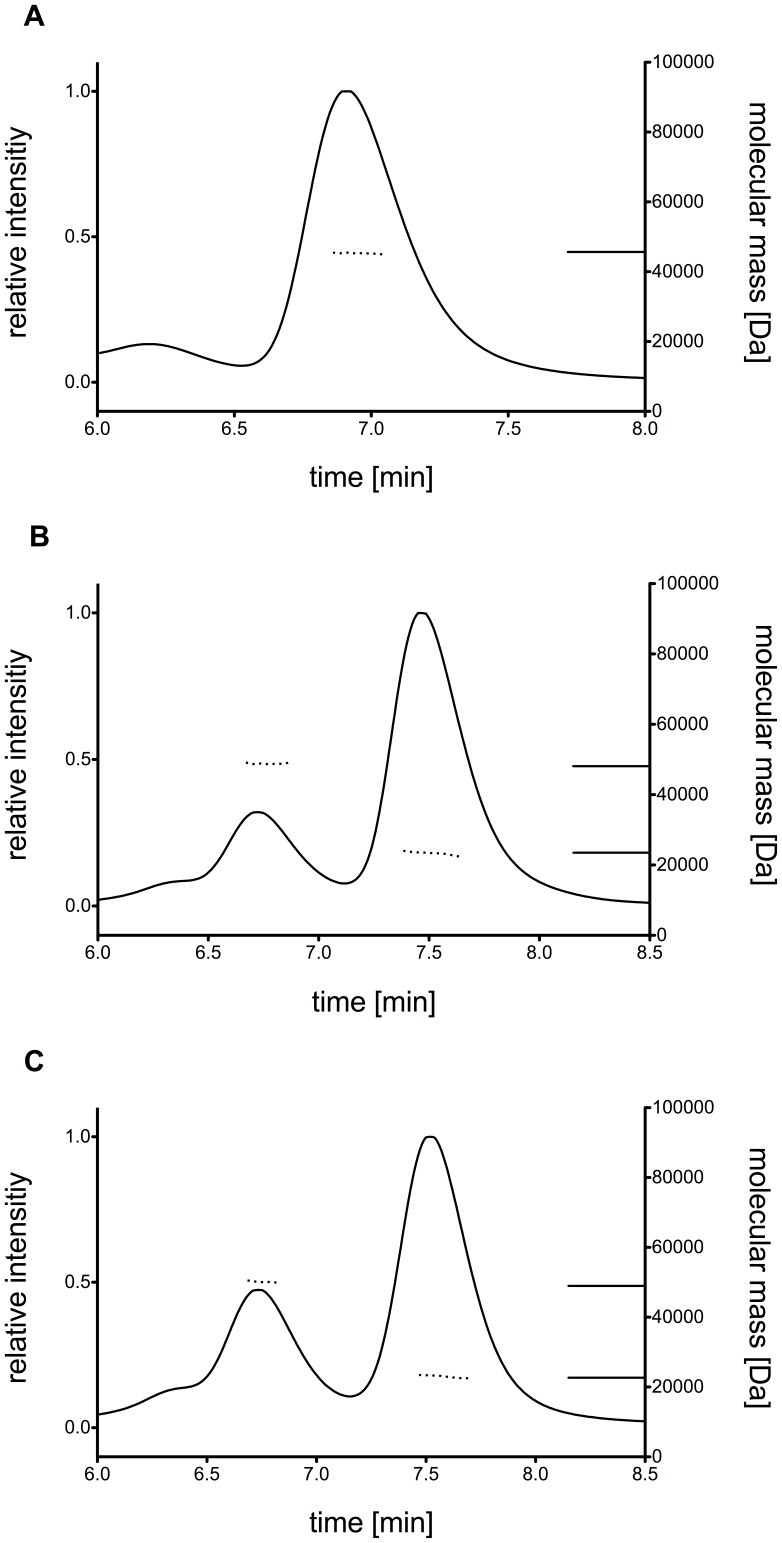
Differential refractive index and molecular mass of hHsp90 variants using multi-angle light-scattering.(A) For wild type hHsp90 CTD a species with molar mass of 45.4±0.1 kDa was determined. Molar masses of higher oligomeric species could not be specified due to insufficient separation. (B, C) Hot spot mutants of hHsp90 CTD, CTDY689A/I692A/L696A (B) and CTDI688A/Y689A/I692A (C), revealed species with molar masses of 23.5±0.2 kDa and 23.2±0.2 kDa, respectively, and additional species with molar masses of 48.7±0.5 kDa and 50.1±0.5 kDa, respectively. Furthermore, also higher oligomeric species were detectable but could not be analyzed with respect to molar masses.